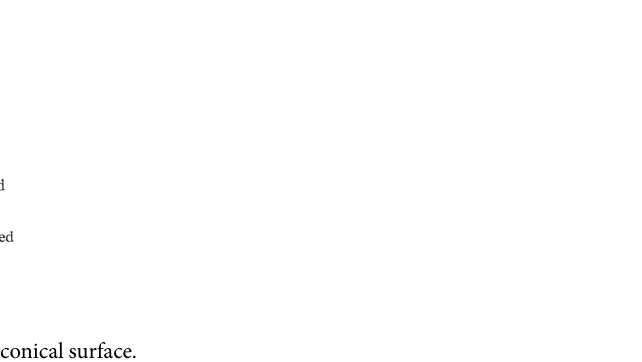
Figure 3. Four different features of a conical